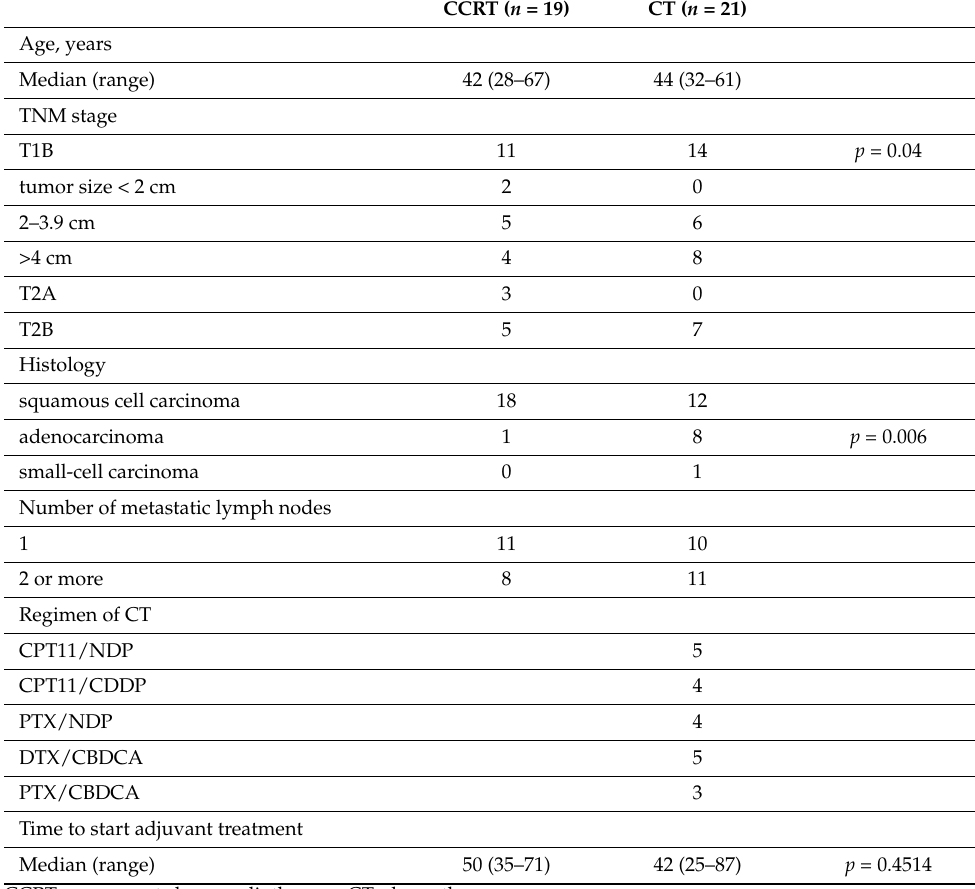
Table 1. Patient